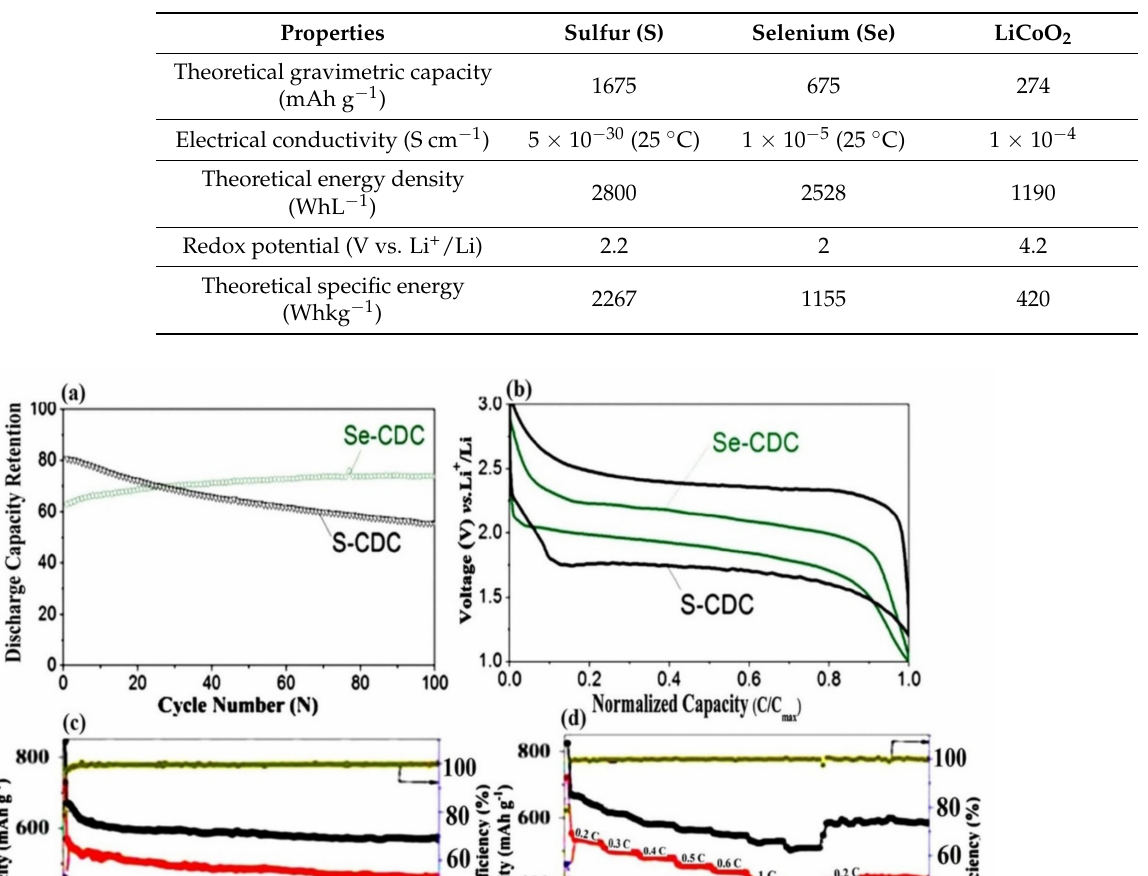
Table 1. Electrochemical properties of Se, S, and LiCoO 2 .